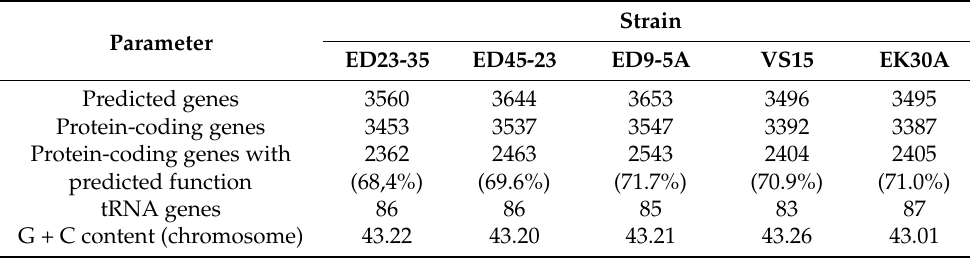
Table 3. General characteristics of the genomes.